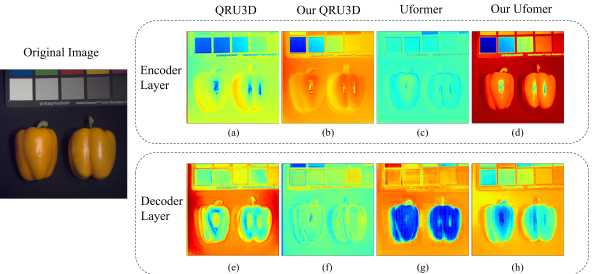
Figure 10. Comparison of feature maps of QRU3D, Uformer, and TRQ3D.